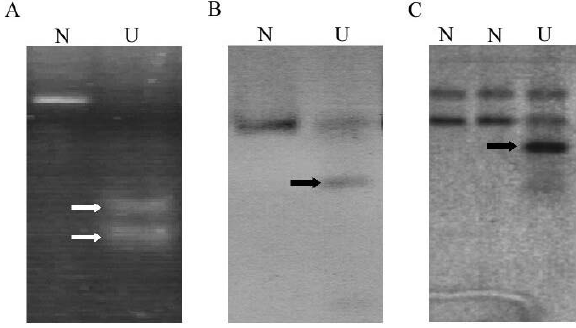
Figure 2 - MSI in TK6 cell clone PCR products for loci (a) nm 23-H1, (B) D8S135, (C) p53 were separated in 7% polyacrylamide. Arrows indicate the new allele. N = Normal; U =